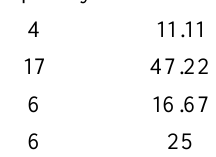
Average Cost of Prescribed Textbooks per